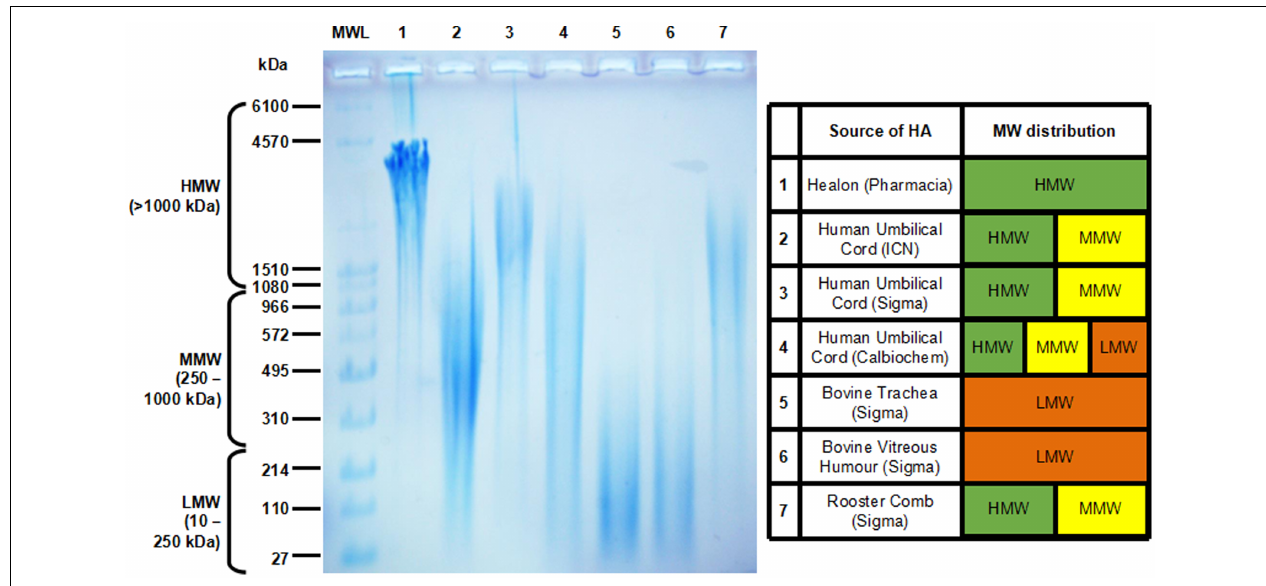
purchased from Hyalose (combined mega, high, and low ladders). HA MW is divided into high (HMW > 1000kDa), medium (MMW, 250-1000kDa), and low